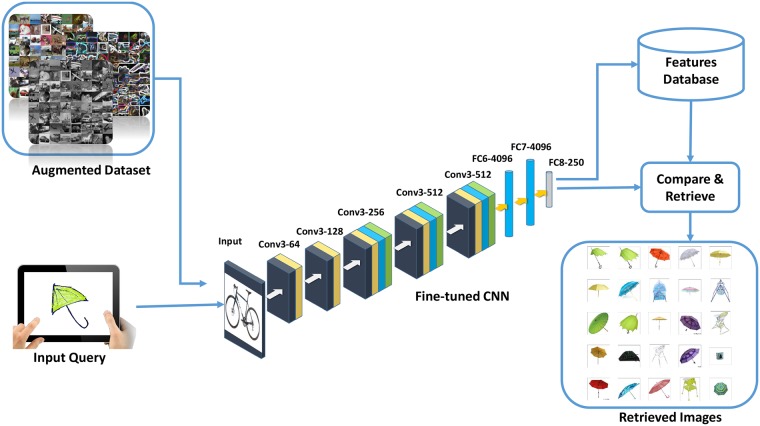
Schematic diagram of the proposed framework for SBIR.